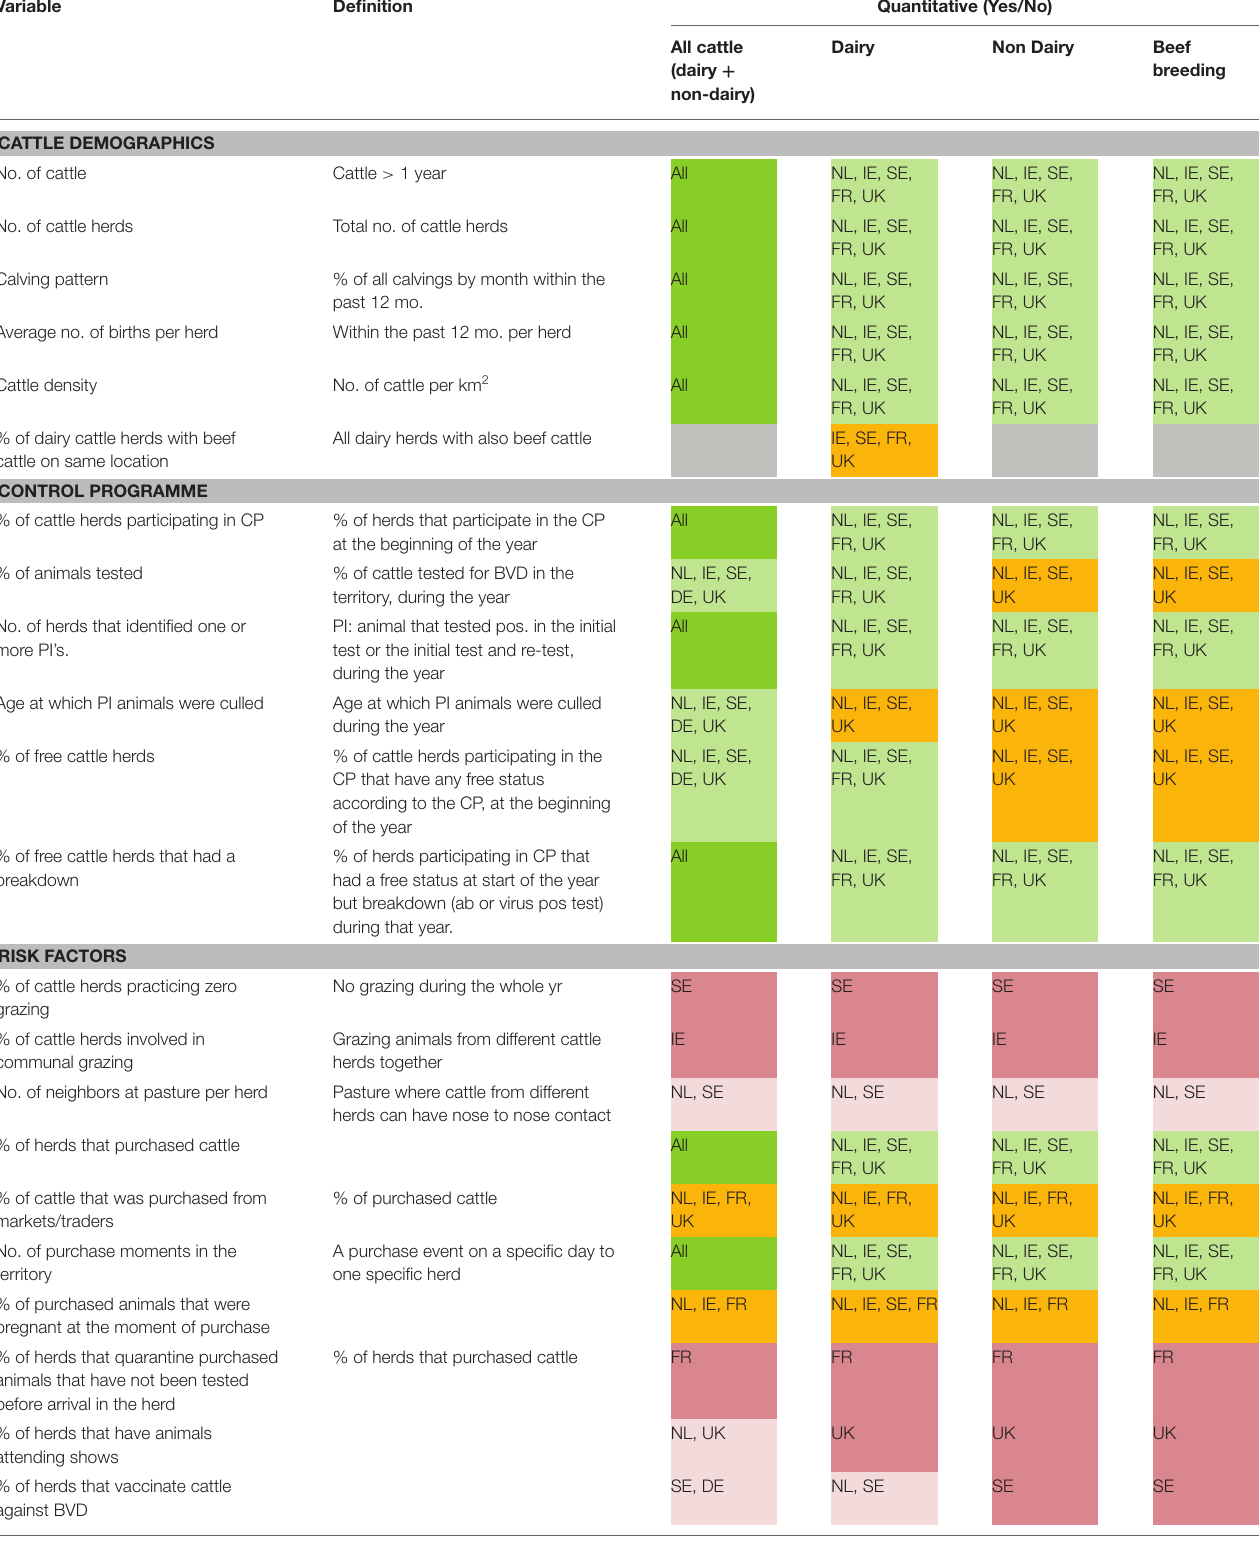
TABLE 5 | Data availability in six European countries for variables on cattle demographics, control programmes and risk factors regarding confidence of freedom from BVDV infection.